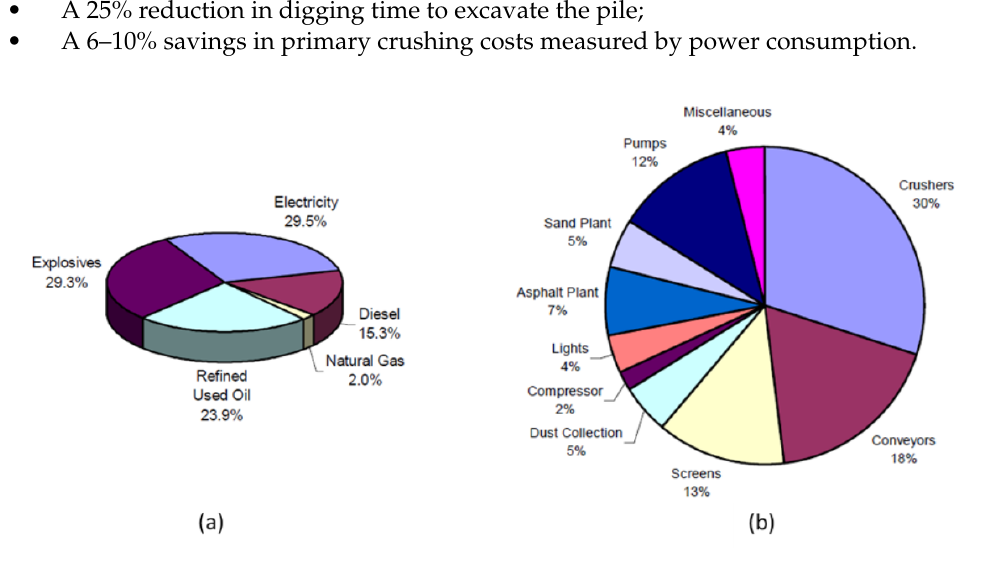
Figure 2. The typical breakdown of energy costs in an average-size mining enterprise ( a ); and electric-energy consumption share in the crushing facility of asphalt plant ( b ) [5].